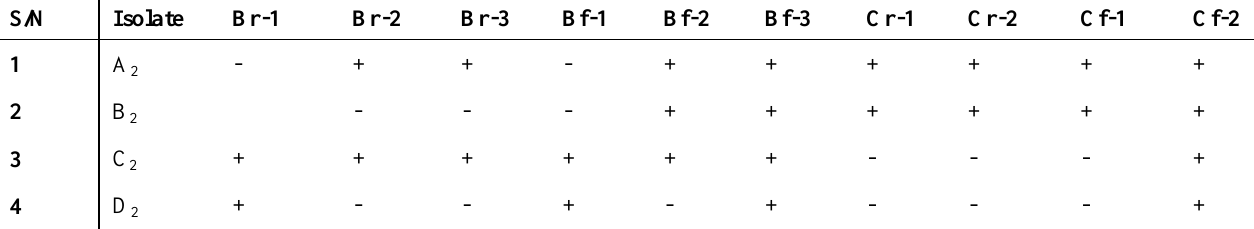
Table 5. Morphology of the bacterial isolates in meat samples (beef and Chicken).